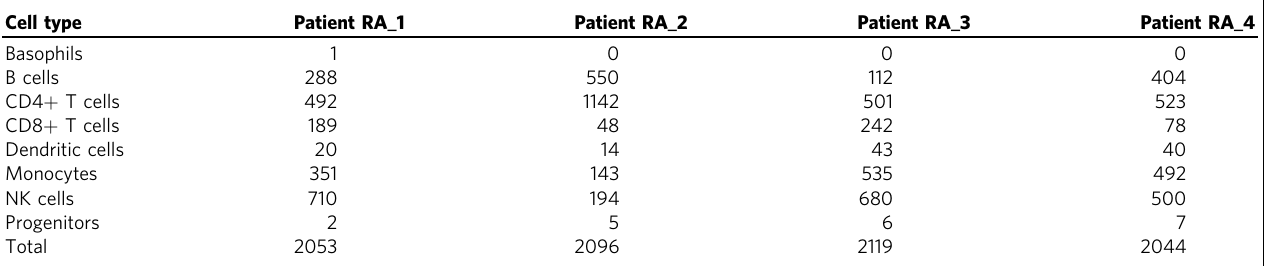
Table 2 Number of cells of each cell type annotated by SingleR that were obtained from each patient in the RA PBMC dataset. Cell